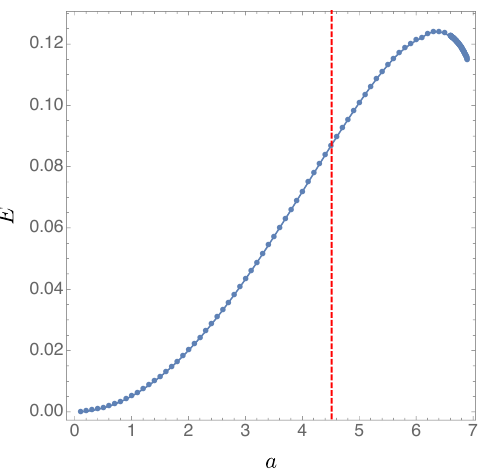
Figure 7 . Total energy E as a function of a , for n = 8. The verticle dashed line corresponds to a = a ergo and the curve ends at a max .